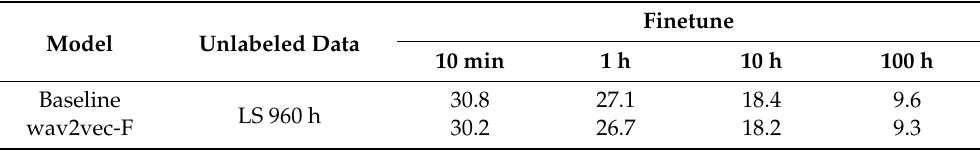
Table 4. The results (WER) on Librispeech test set when training on the low-resource labeled data setups of 10 min, 1 h, 10 h, and the clean 100 h subset of